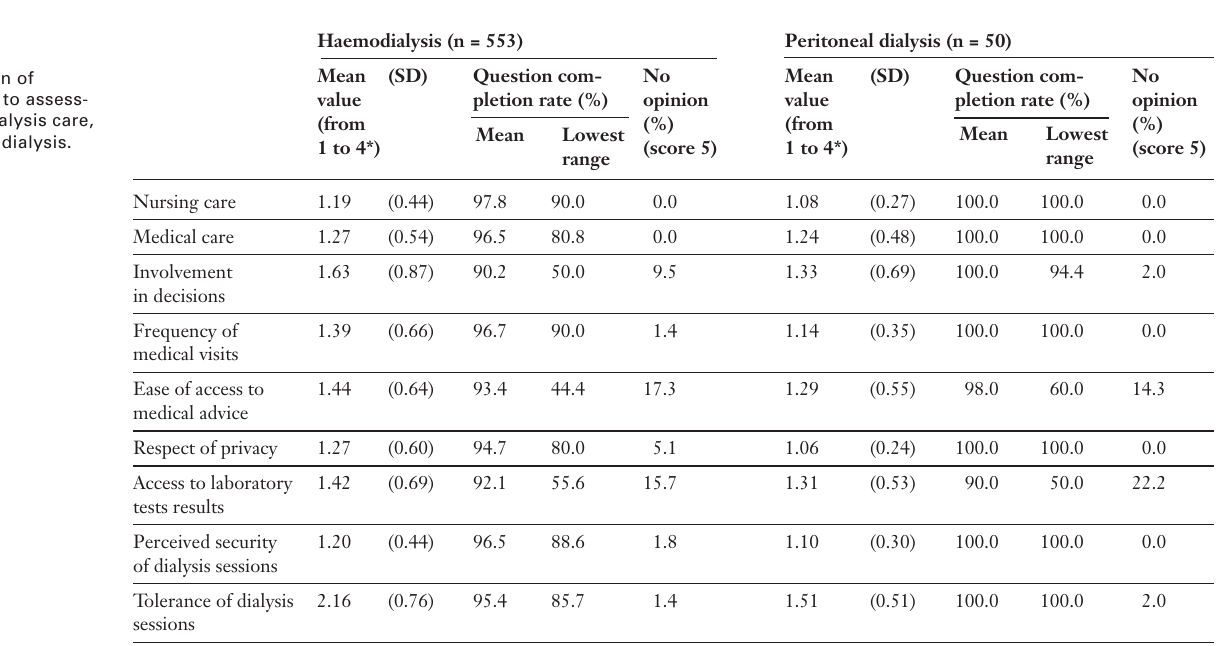
Table 2 Distribution of responses to assess- ment of dialysis care, by type of